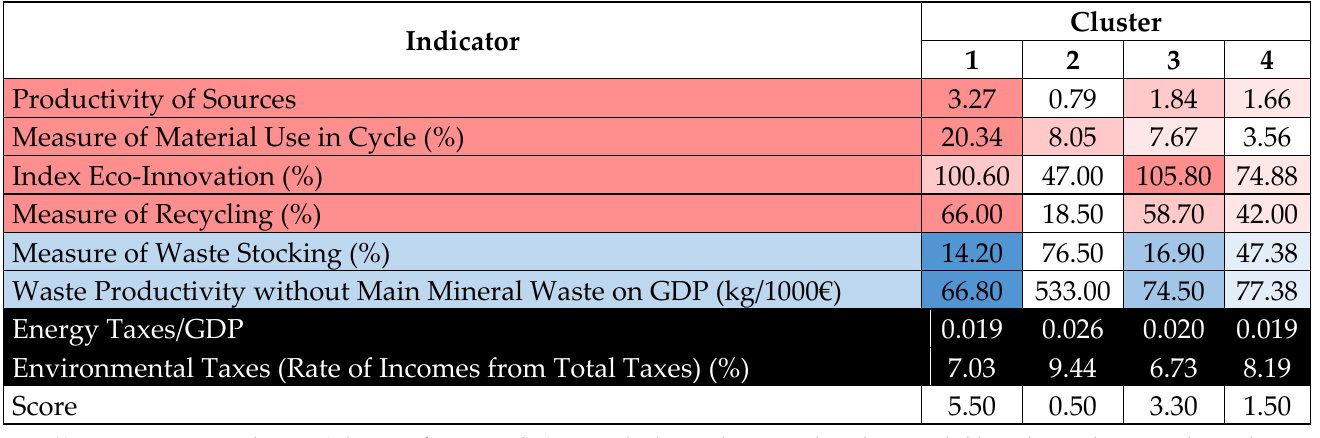
Table 4. Average values of indicators in each cluster-year.